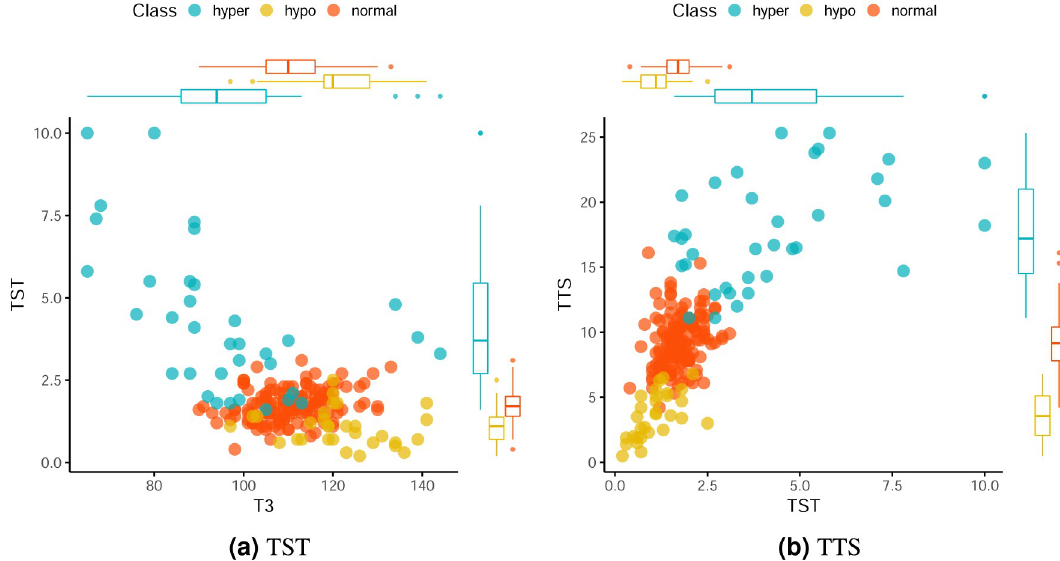
Fig 5. Scatter plots and boxplots for the Thyroid Gland dataset. ( a ) TST. ( b )